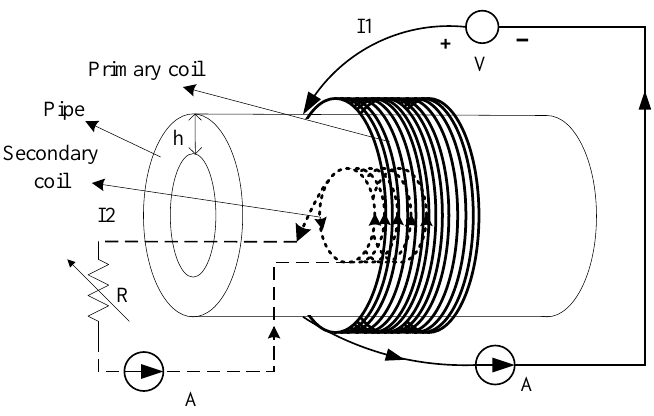
Figure 1. Diagram for power transfer through a metal pipe using the IPT method, redrawn from Imoru et al. [4].